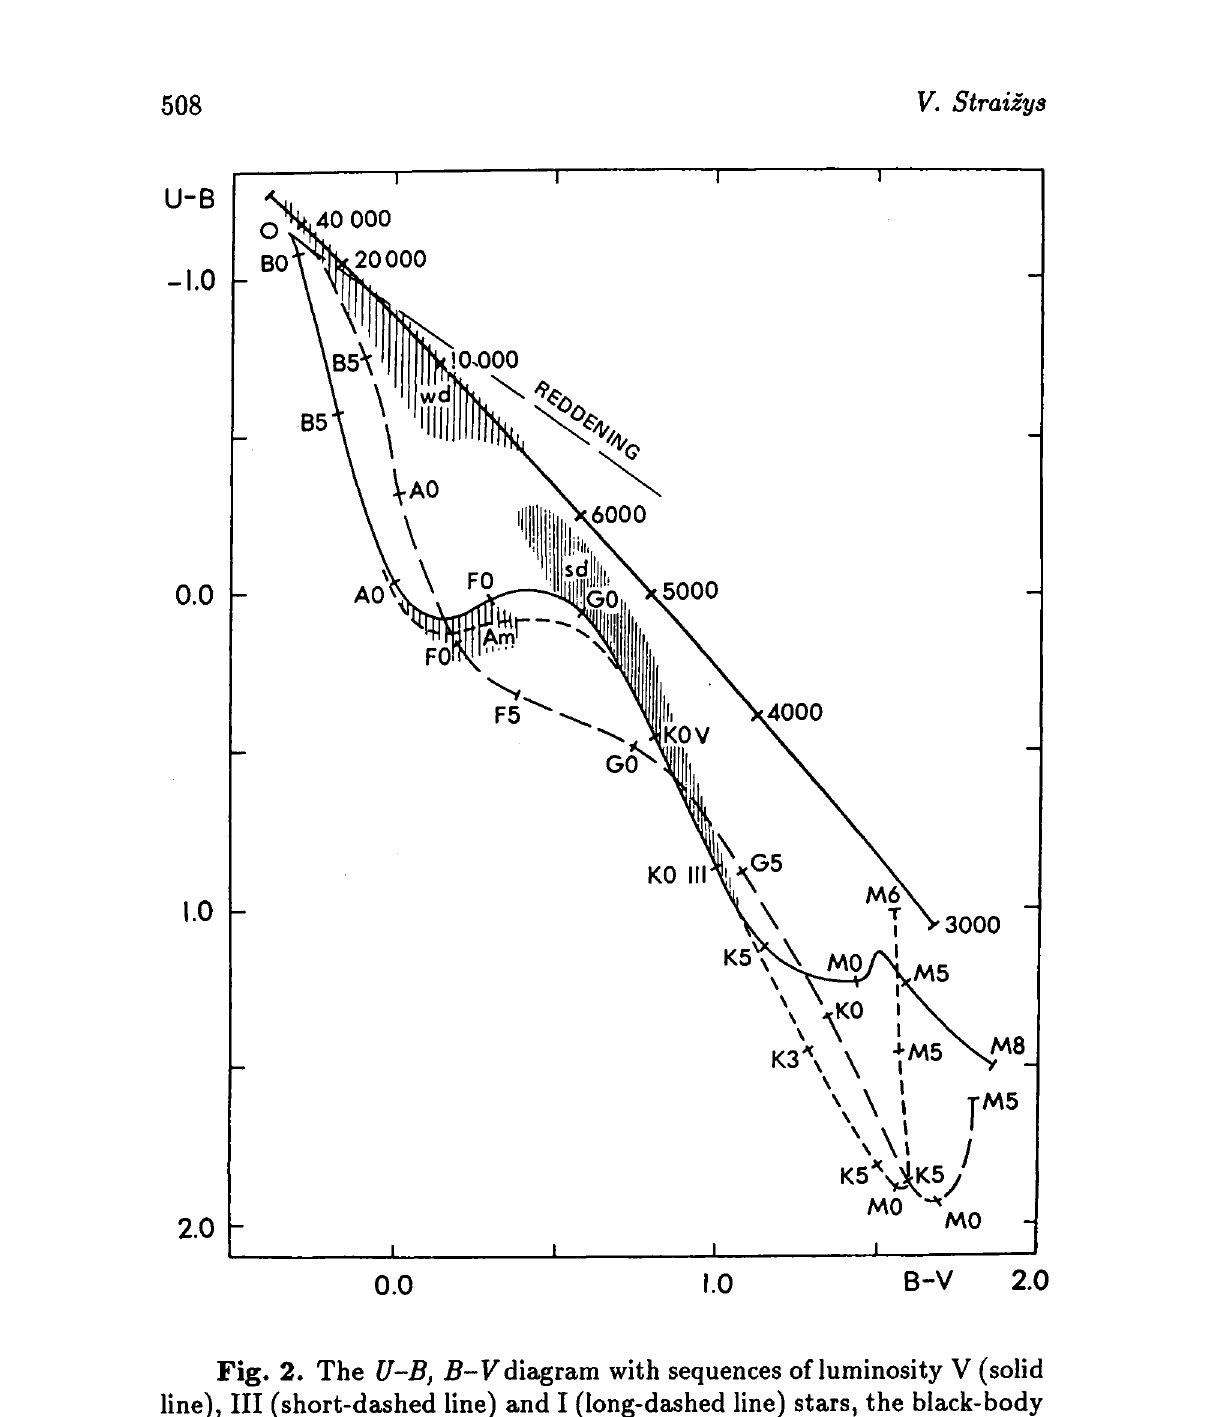
Fig. 2. The U-B, j9-Vdiagram with sequences of luminosity V (solid line), III (short-dashed line) and I (long-dashed line) stars, the black-body line with temperature ticks and the positions of white dwarfs, metallic-line stars and